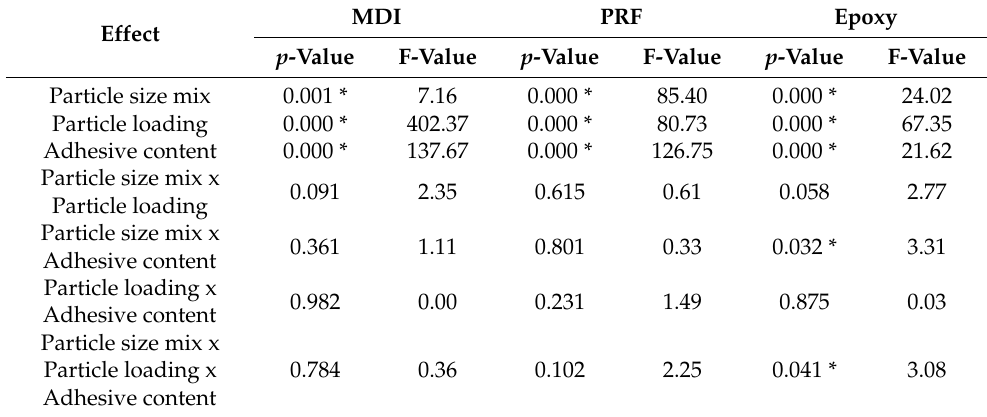
Table 8. Test of fixed effects of internal bond strength of MDI, PRF and epoxy ULHPB.